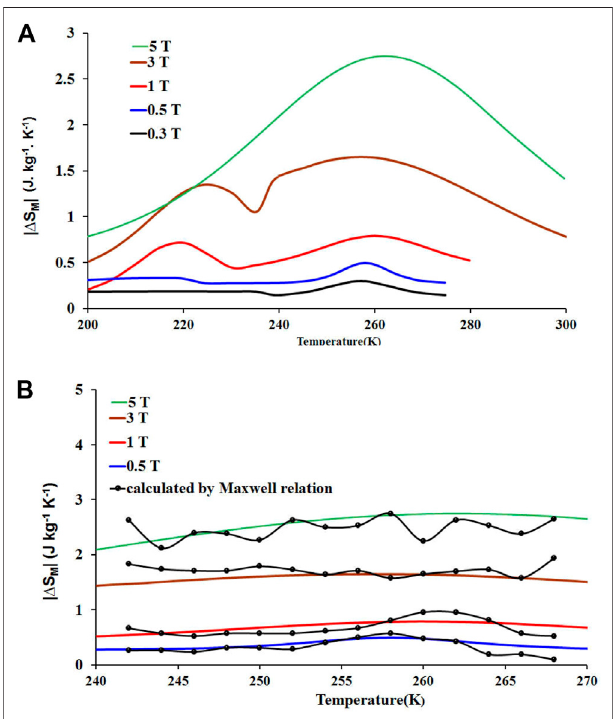
FIGURE 3 | (A) Δ S M and (B) Δ S M ( T ) was calculated by Maxwell relation, and Δ S M ( T ) was calculated by a phenomenological model.